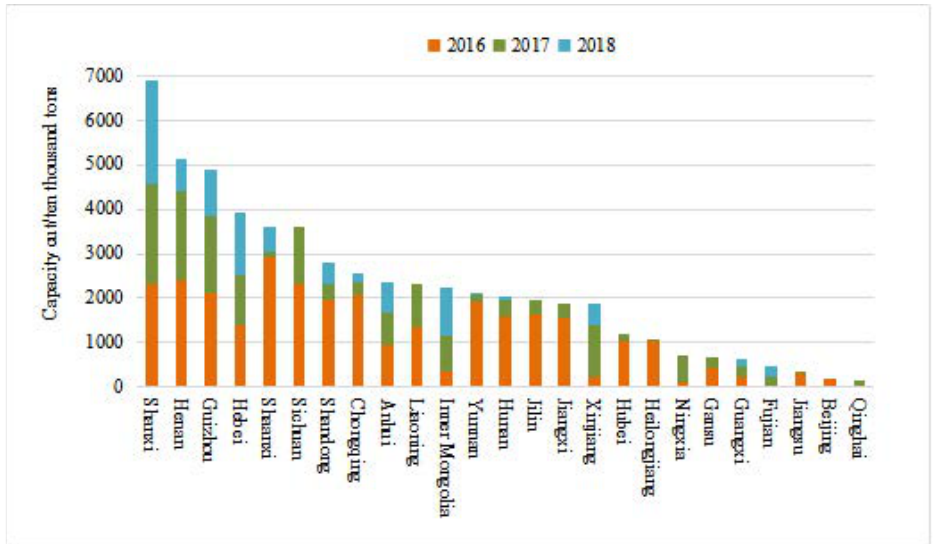
Figure 4. Provincial annual coal capacity cut in China.